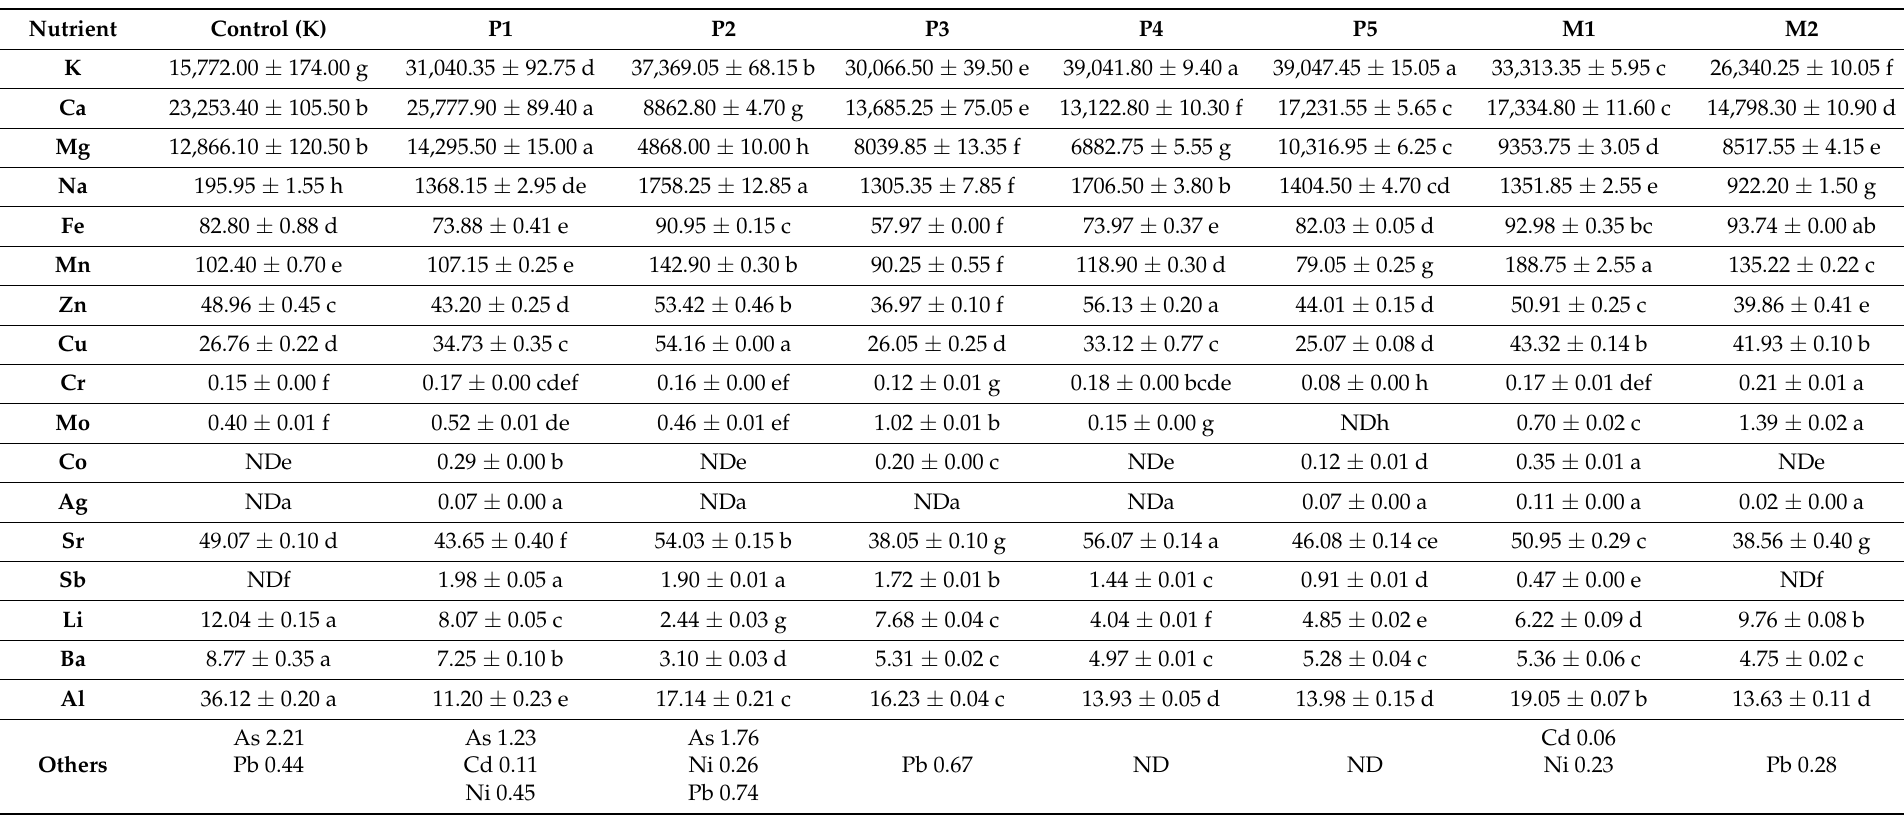
Table 5. Macronutrient, micronutrient, and fragment compounds analyzed from leaves of diploid, tetraploid, and mixoploid C. fragrans plants (mg.kg − 1